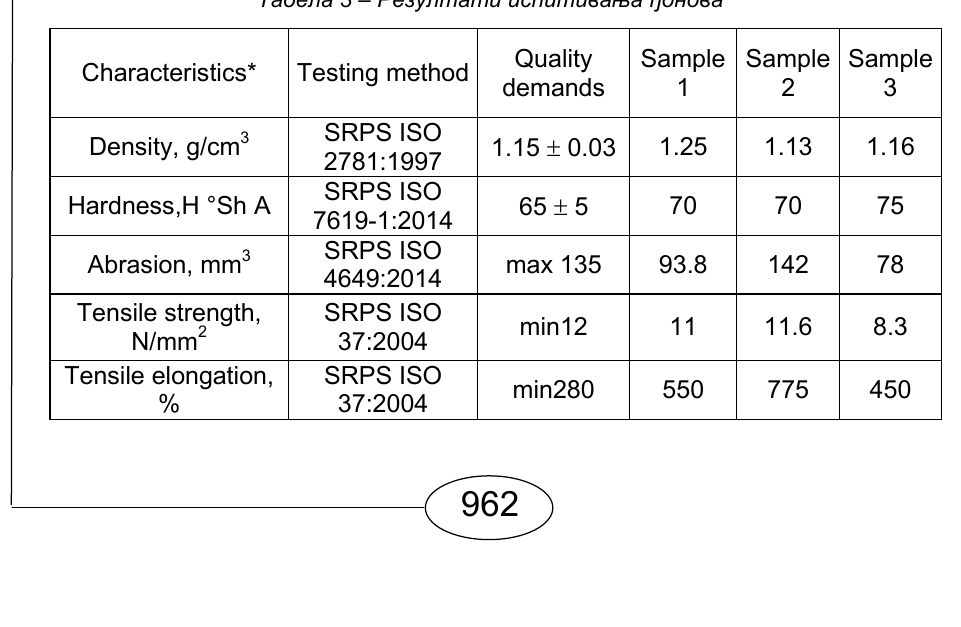
Table 3 – Results of testing the soles Таблица 3 – Результаты испытаний подошв Табела 3 – Резултати испитивања